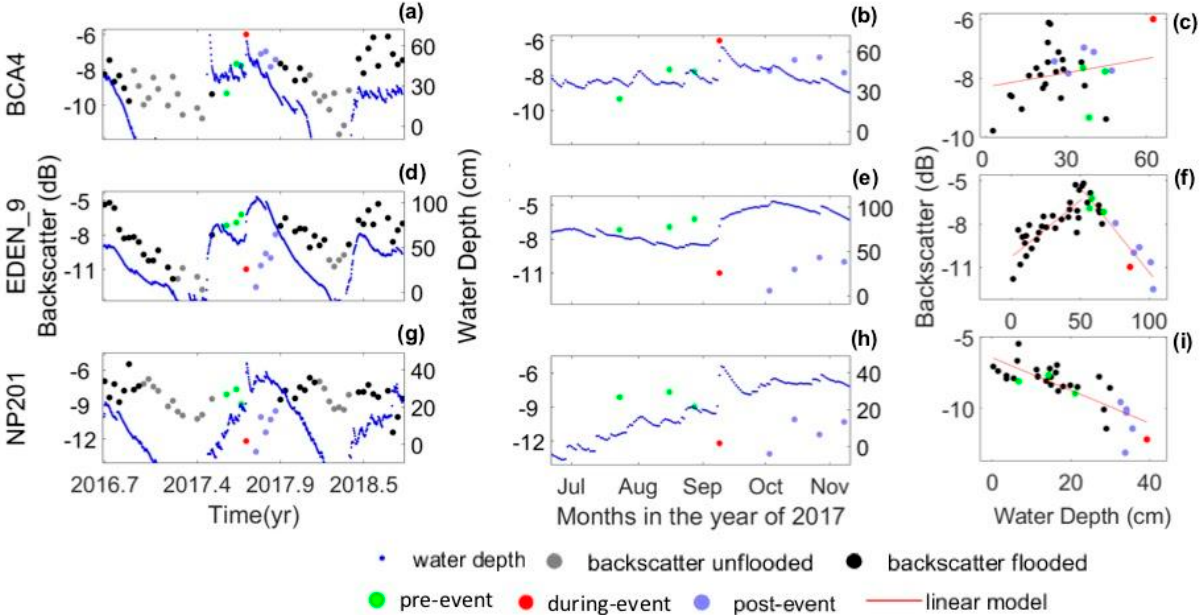
Figure 4. Backscatter changes in response to variations in water depths for three selected water gauges. Three rows represent water gauges ‘BCA4’, ‘EDEN_9’, and ‘NP201’, respectively. ( a,d,g ) Temporal changes in backscatter and water depths from September 2016 to September 2018. Small blue dots represent daily water depth; black and grey dots represent SAR backscatter values under flooded and unflooded conditions, respectively; green, red, and purple dots represent pre-, during-, and post-event backscatter, respectively. The x-axes represent time in decimal year format. Water depth measurements under unflooded conditions (negative values) were excluded. ( b,e,h ) Zoomed-in view for the period from July to November 2017, highlighting pre-, during-, and post-event data. ( c,f,i ) Scatter plots of backscatter and water depth under flooded conditions from September 2016 to September 2018 with red lines representing least-squares best-fitting models. For water gauge ‘BCA4’, backscatter was in phase with water-depth variations (Figure 4a). The positive linear σ ◦ -d w relationship was weak (R 2 = 0.04, Figure 4c).